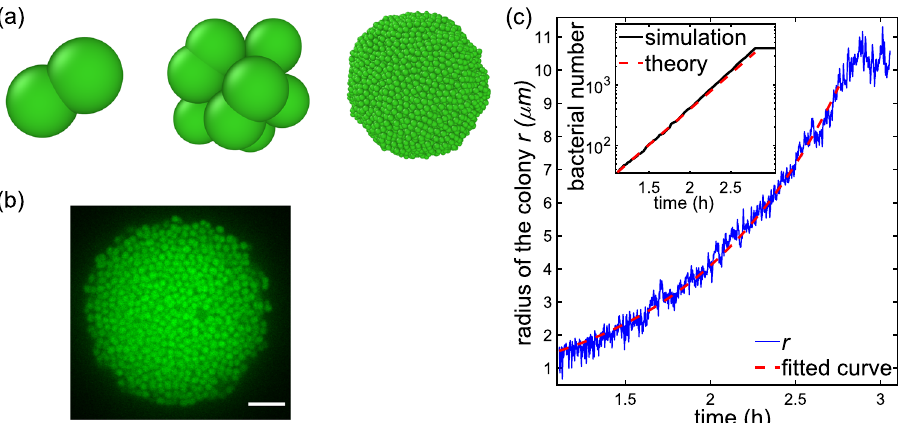
Fig. 2 Simulations of growing colonies. a Simulation snapshots showing colony formation. b Confocal section of a microcolony of fl uorescently labeled N. gonorrhoeae . Scale bar: 5 μ m. c The colony radii increase exponentially with time during the simulations. Growth and division are switched off before the end of the simulation. Inset: the number of cells increases exponentially with time and simulation results agree with an